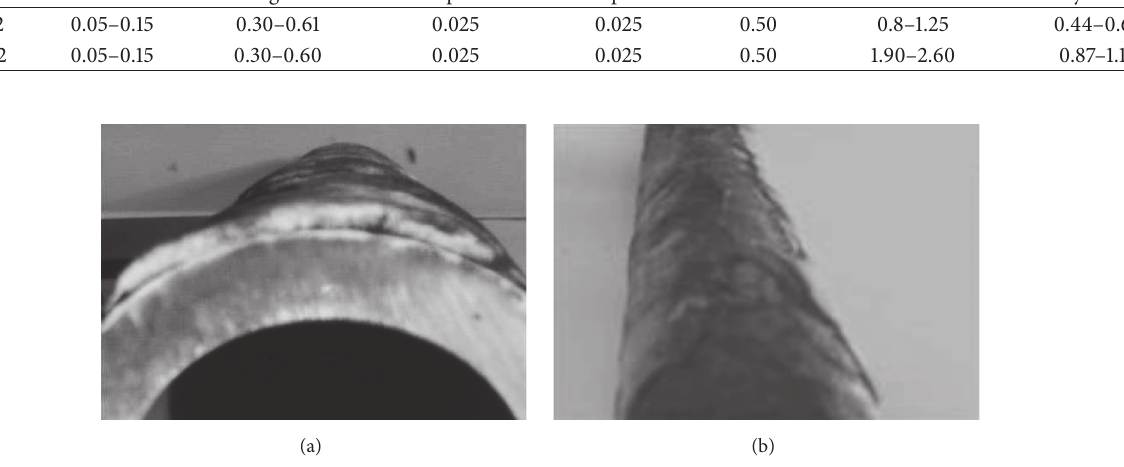
Figure 1: (a) Cross section of a boiler tube with deposits on the surface and (b) surface of a boiler tube after two years in the service